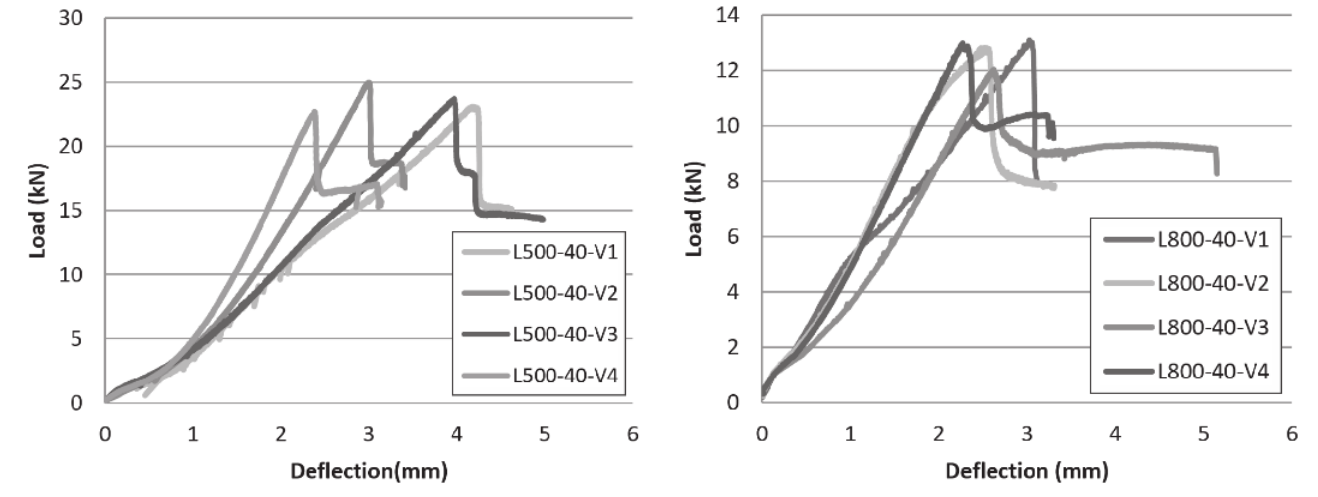
Graph load x deflection: 500 mm span in group